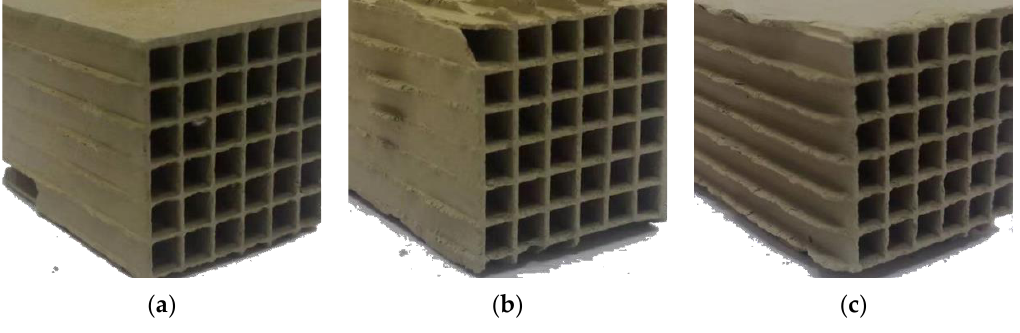
Figure 1. The structures of the three catalysts: ( a ) V 1.6 Mo 1.7 W 1.8 /TiO 2 ; ( b ) V 2.7 Mo 3.0 W 1.0 /TiO 2 ; ( c ) V 1.6 Mo 2.5 W 0.5 /TiO 2 .